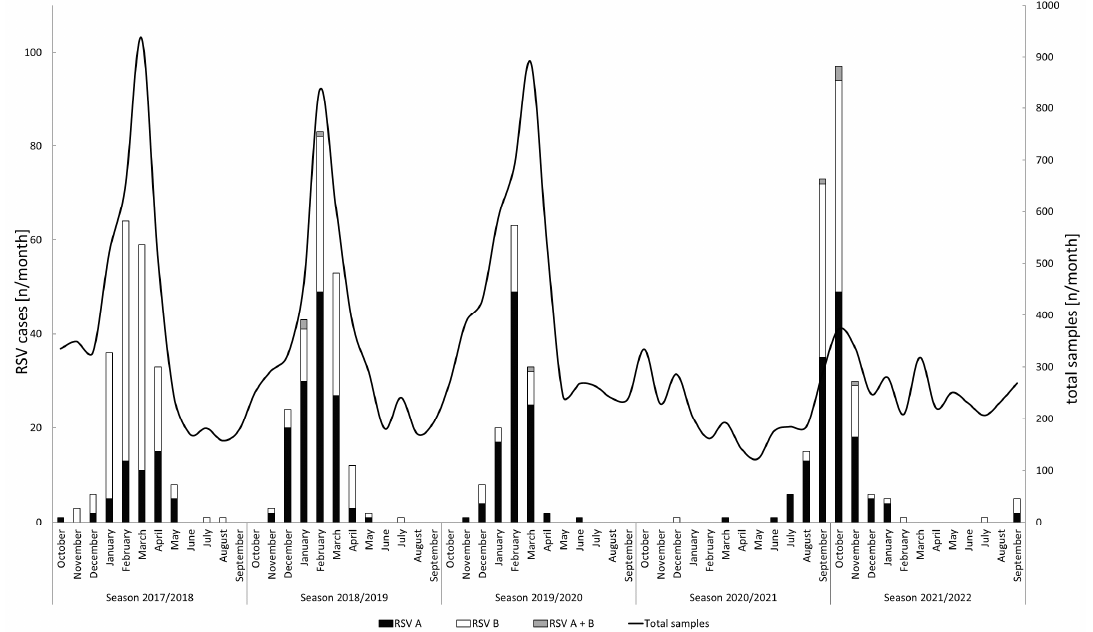
Figure 1. Monthly total numbers of tested samples and RSV cases ( n = 803) stratified by subtype. Note the two different y-axes: the left axis refers to the bar charts and shows the absolute number of detected RSV cases while the right axis refers to the absolute number of tested samples, as represented by the line graph. The x-axis is labeled according to the pre-pandemic definition that was used to define the start and end of a respiratory